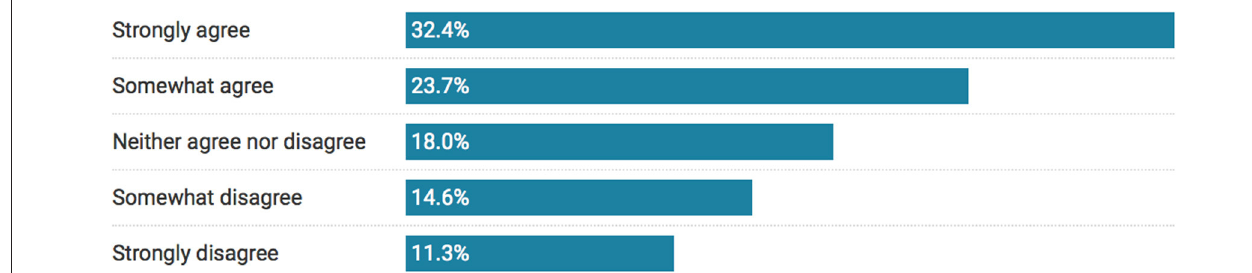
FIGURE 1 | Level of agreement about banning food waste from landfills.